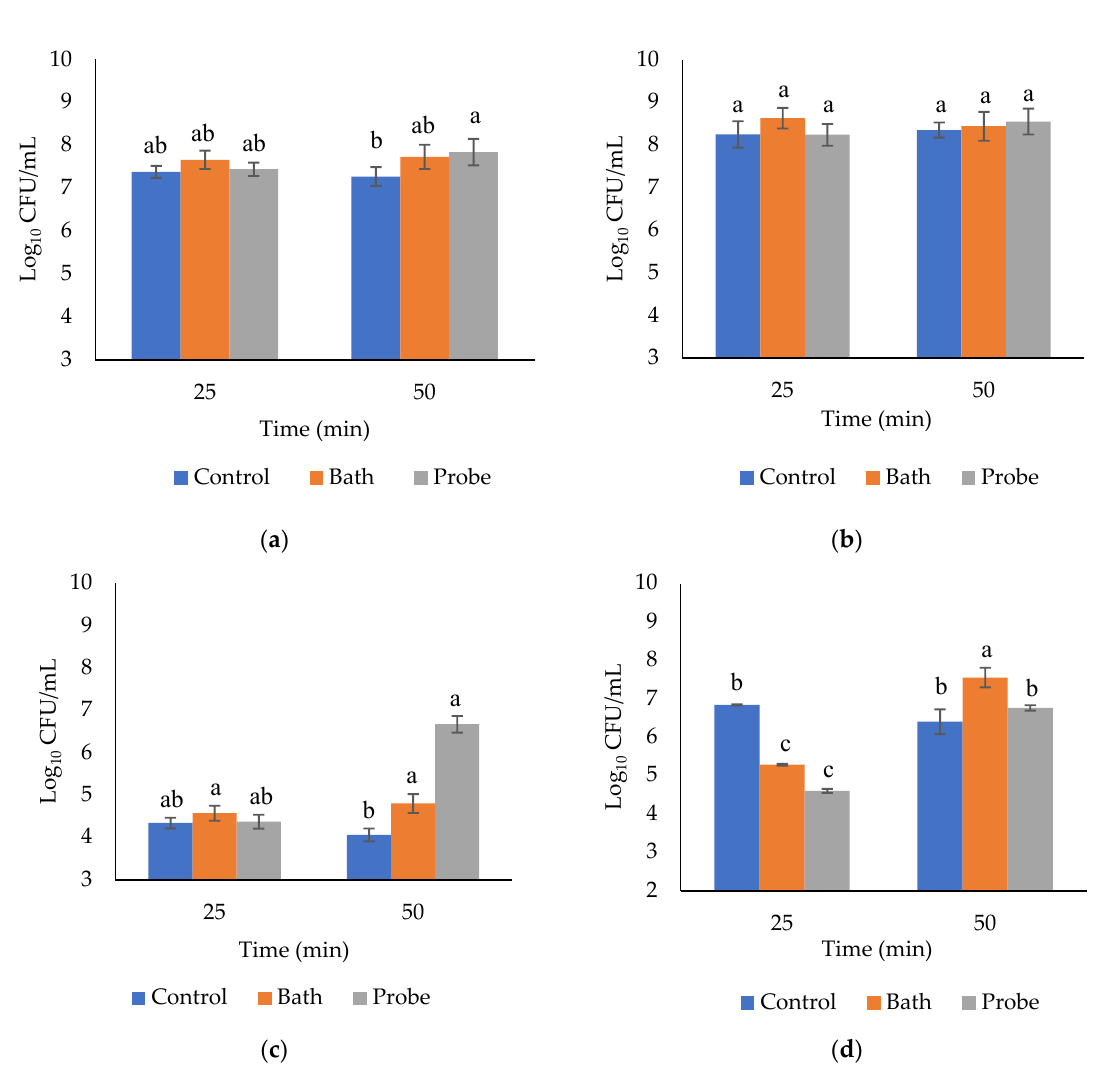
Figure 2. Effect of the combination of the HIU system and HIU time on the count of mesophiles ( a ), psychrophiles ( b ), lactic acid bacteria ( c ), and total coliform bacteria ( d ) of bovine Longissimus lumborum . a,b,c Different letters in the columns within the same graph indicate significant differences between treatments ( p < 0.05).